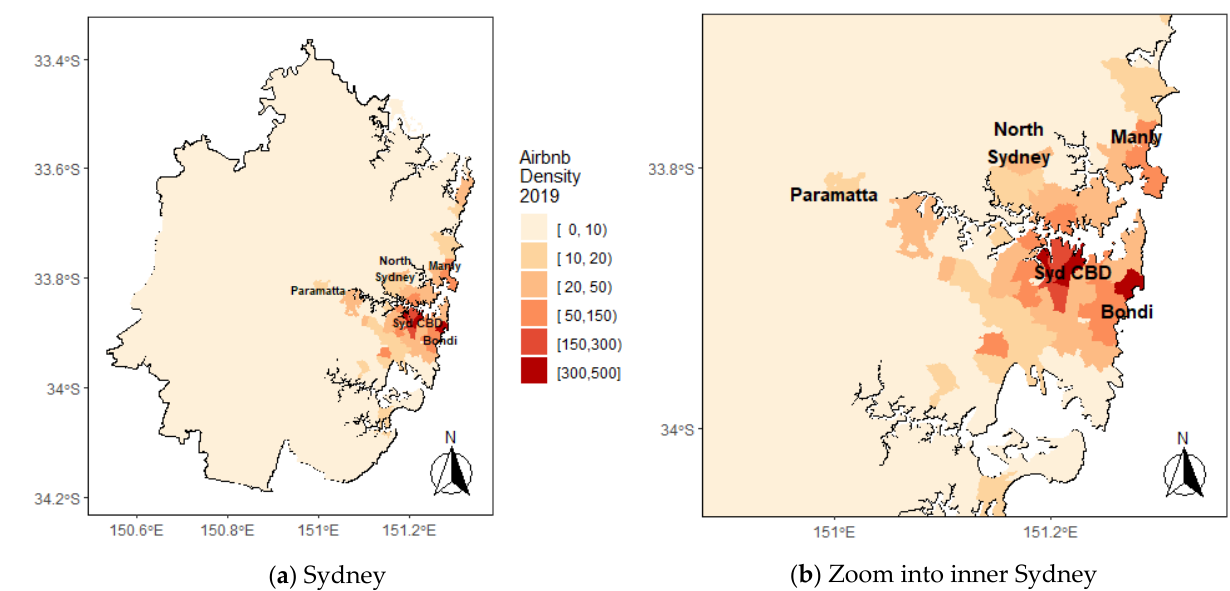
Figure 1. Distribution of Airbnb activity throughout Sydney.